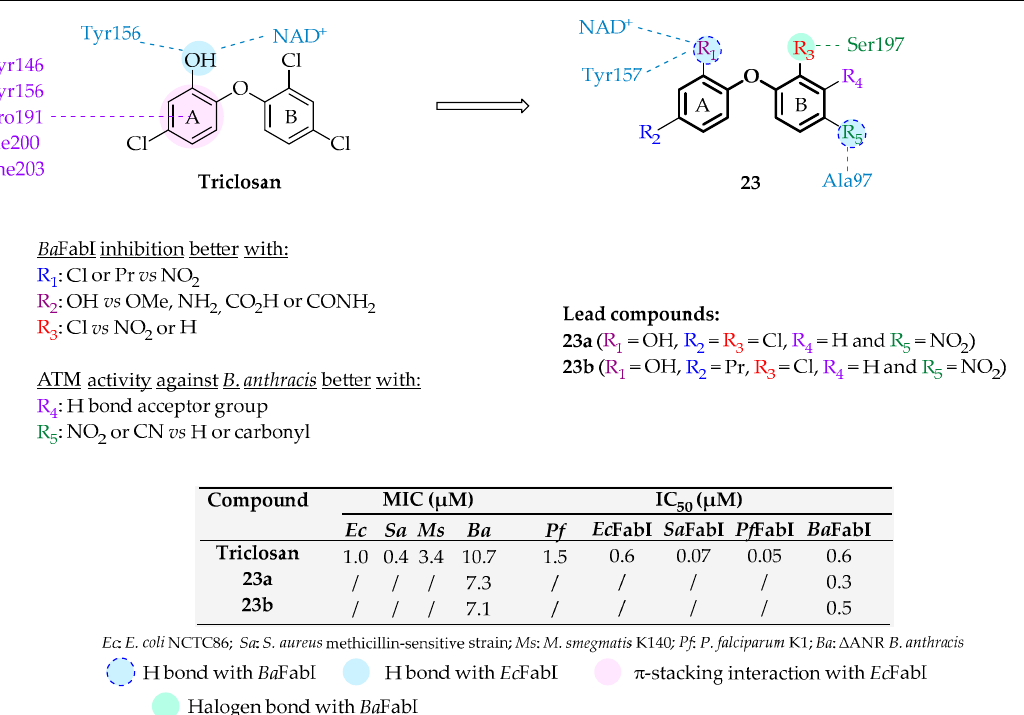
Figure 26. Structure, SAR and representation of main interactions with Ec FabI and Ba FabI of triclosan and its analogues 23 and in vitro activities of lead compounds [131–134,144,145]. In 2012, Gerusz et al. engaged in rational drug-design study based on triclosan [146]. Thirty-two derivatives 24–26 (Figure 27) were designed by modulating substituents of both rings A and B and sometimes replacing the phenyl ring B by pyridine ( 24 ). In the first instance, fifteen derivatives 24 were designed by changing the nature of the substituents in R 1 of the ring A, while ring B was a 2-fluoropyridine. Replacing the chloride ( 24a ) by a bromide led to improved Ec FabI inhibition (IC 50 = 0.1 vs. 0.6 µM), while alkyl and fluoro- alkyl groups were well tolerated. However, no compound displayed better ATB activity than 24a against E. coli . Modulation of the ring B substituents of 25 highlighted that (i) fluoride in ortho -position (R 2 ) increases both inhibitory and ATM activities, (ii) para- sub- stitution (R 3 ) with sulphonamides, amines or carbonyls is well tolerated, and (iii) meta -substitution (R 4 ) strongly decreases the inhibitory activity. Furthermore, compounds 25a-c displayed dual activity, since they also inhibited growth of S. pneumoniae , which possesses exclusively FabK as ENR. Both broad-spectrum activity and the strong an- tistaphylococcal activity of 25c (MIC = 0.2 µM) led to its pharmacomodulation. While flu- oride was added on the ring A, the para -acetyl group was substituted with more hydro- philic derivatives (amides or carboxylic acids). Among the seven compounds 26 synthe- sized, all displayed interesting inhibitory activity (IC 50 ( Sa FabI) = 0.01-0.2 µM). Nonethe- less, 26a exhibited better antistaphylococcal activity than triclosan (MIC = 0.04 vs. 0.1 µM) and no cytotoxicity on HepG2 cell lines. A docking study with this promising compound, also called MUT056399 , and Sa FabI highlighted: (i) hydrophobic interactions between the ethylic chain of 26a and the triad Val201-Tyr147-Phe204, (ii) hydrogen bonds between ring A, Tyr157 and NAD + (as observed with Ec FabI and triclosan , Figure 26), (iii) hydrophobic interactions between ring B and Met160 and (iv) hydrogen bond between the ring B oxy- gen carbonyl and Ala97. Preclinical studies of 26a on mice and dogs did not exhibit tox- icity or safety risks which could prevent its use. Furthermore, the in vivo efficacy on mice validated 26a , as an interesting antistaphylococcal, with ED 50 values ranging between 19.3–45.1 mg/kg for several methicillin-resistant S. aureus strains. However, the preclinical assays seem to be stopped for unknown reasons.